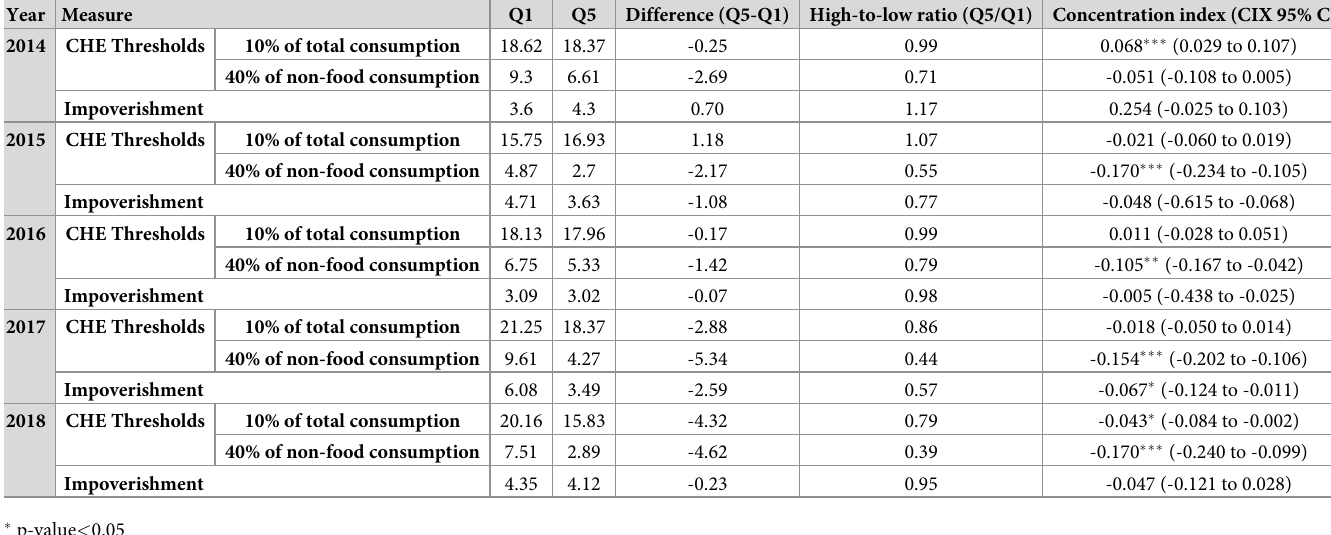
Table 6. Inequalities in the incidence of CHE and impoverishment in the 2017 and 2018 ILCS in